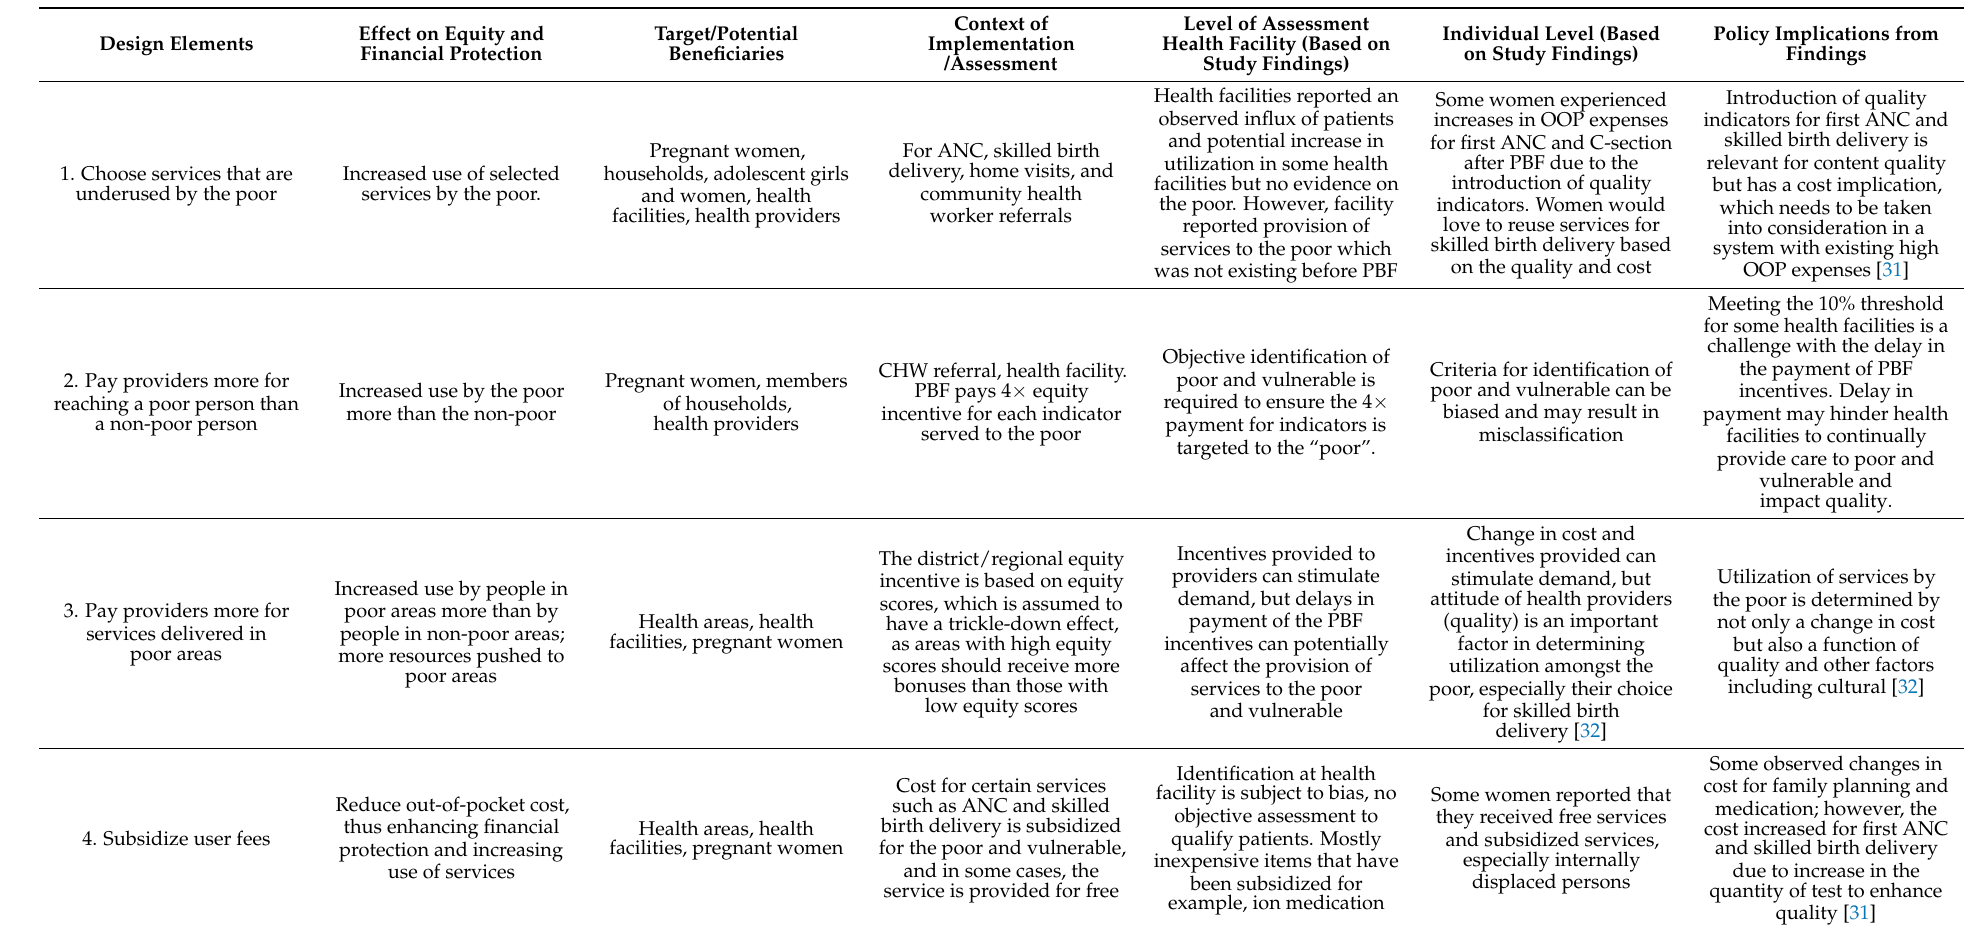
Table 6. Using study findings to understand the PBF design elements and anticipated effect on equity for ANC and skilled birth delivery in